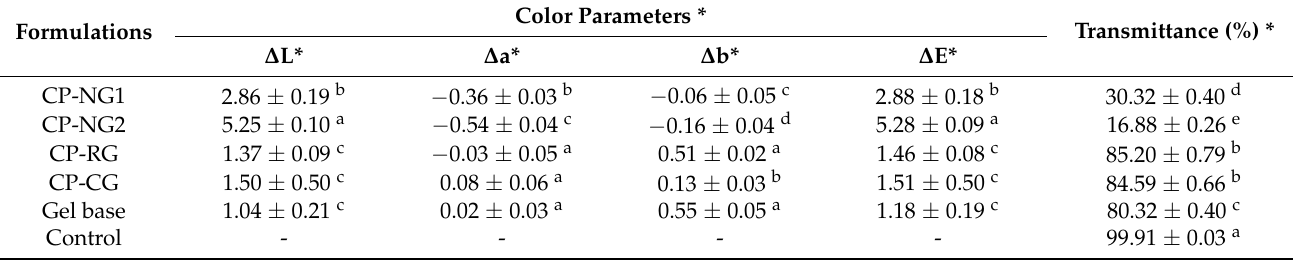
Table 5. Color parameters and transmittance of the gel